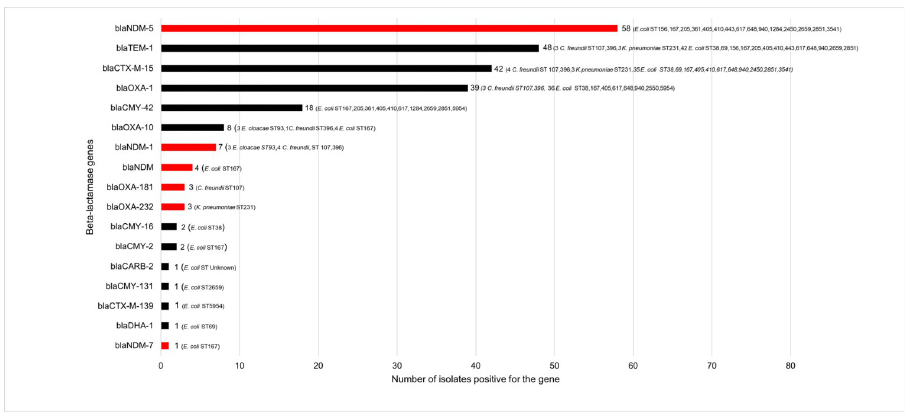
Fig 3. Acquired beta-lactamase–encoding genes. Carbapenemase-encoding genes are highlighted in red.